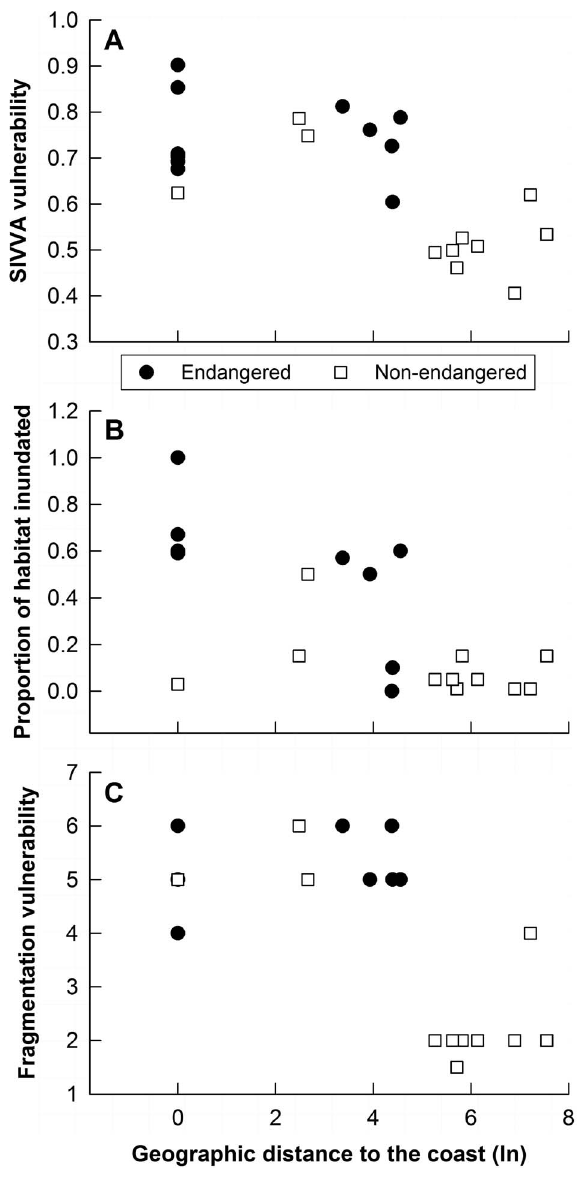
Figure 5. Associations between geographic distance to the coast and vulnerability. Correlation between geographic distance to the coast (natural log) and ( A ) the vulnerability module of the Standardized Index for Vulnerability and Value Assessment (SIVVA) (r= 2 0.842, p , 0.001), ( B ) the proportion of habitat inundated under 1 m of sea level rise (r= 2 0.675, p , 0.001), and ( C ) vulnerability to habitat fragmentation (r= 2 0.672, p , 0.001). Black circles=threatened and endangered subspecies; white squares=non-listed